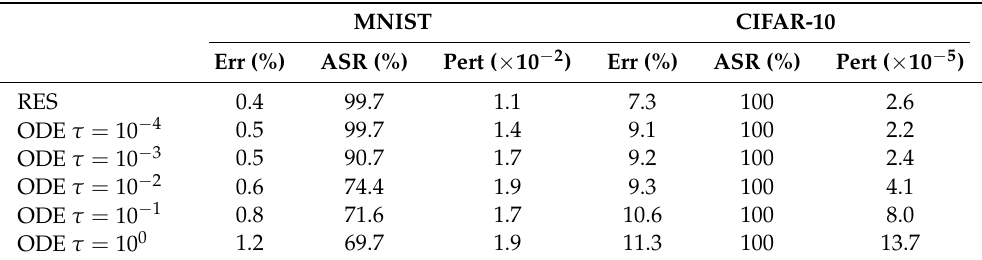
Table 1. Classification error (Err, %), Carlini and Wagner attack success rate (ASR, %), and mean L 2 norm perturbation (Pert) of RES and ODE on MNIST and CIFAR-10 test sets; obviously only for ODE are quantities varying the test-time adaptive solver tolerance τ ( τ attack = τ test )